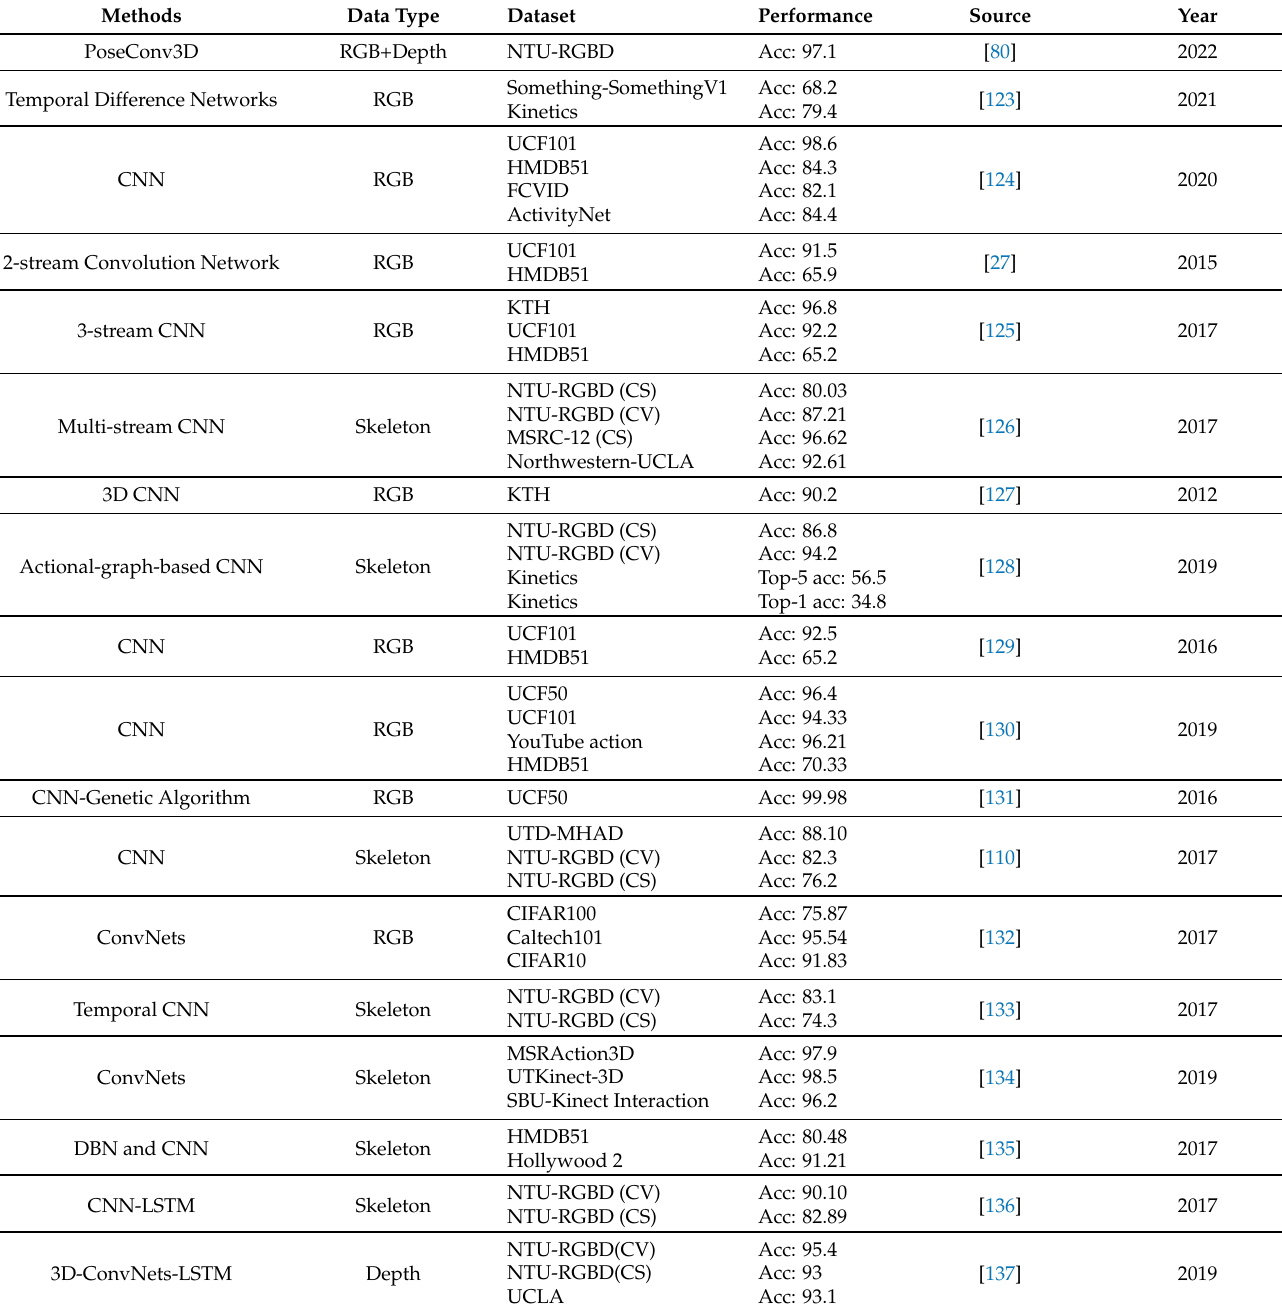
Table 2. CNN feature based state-of-the-art methods for